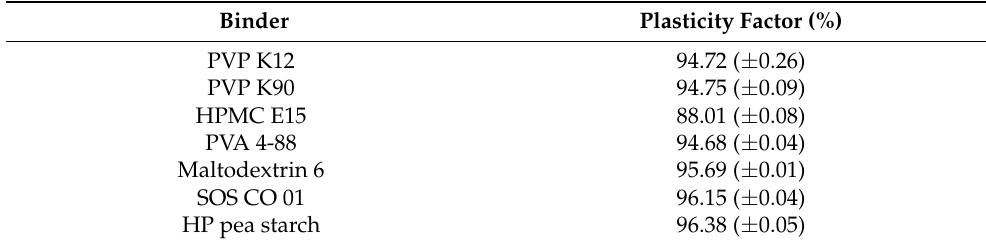
Table 5. Plasticity factor (%) of each